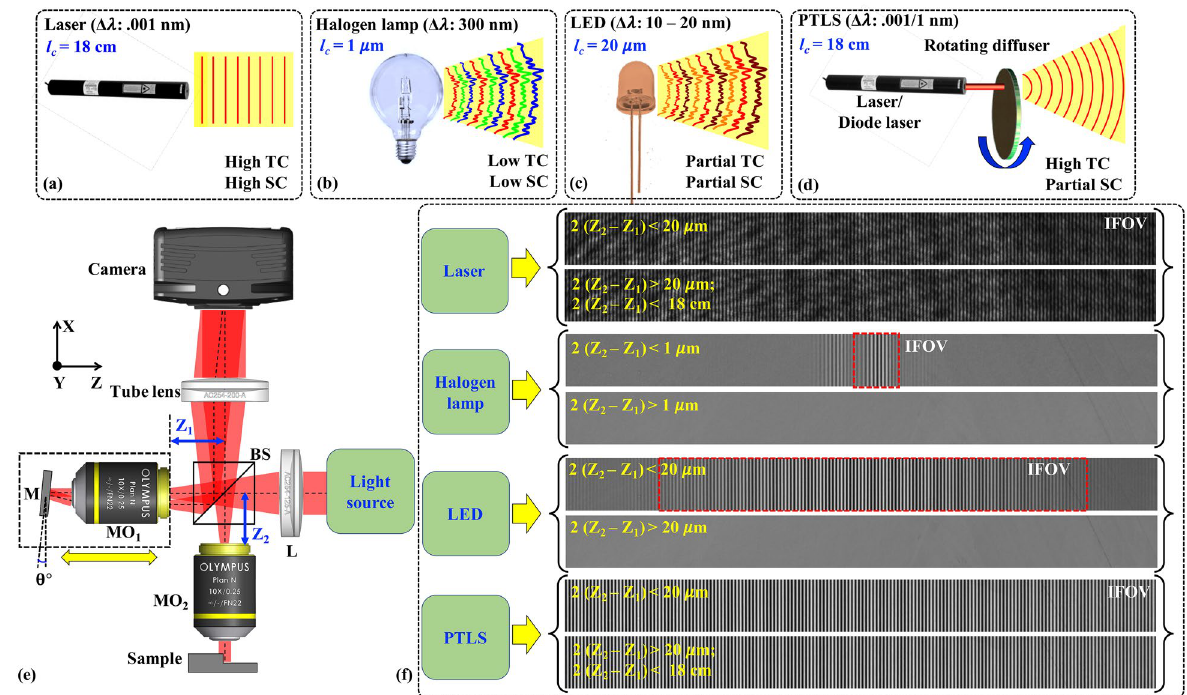
Figure 1. Effect of coherence properties of different light sources in QPM: ( a – d ) Exhibit light field illumination wavefront profiles in case of laser, halogen lamp, LED and PTLS, respectively. ( e ) Schematic Linnik interferometer based QPM system. BS beam splitter, L lens, M mirror, MO 1,2 microscope objectives. ( f ) Interference field of view (IFOV) and noise comparison of different light sources employed in QPM